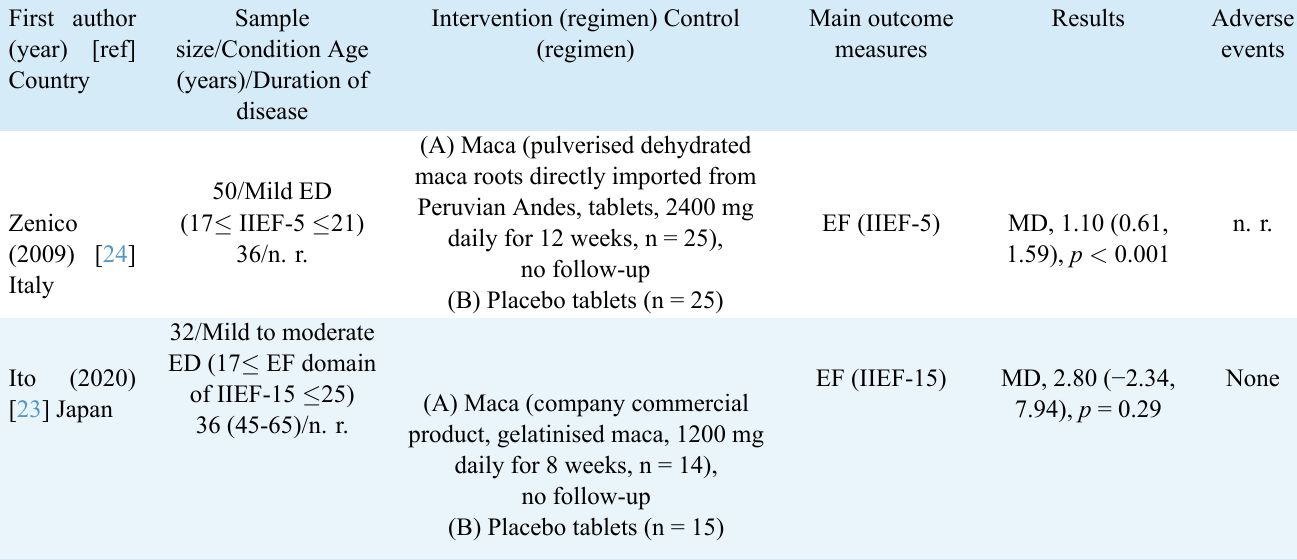
FIGURE 1. Study selection process. ED: erectile dysfunction. TABLE 1. Summary of randomized clinical trials with maca for men with erectile